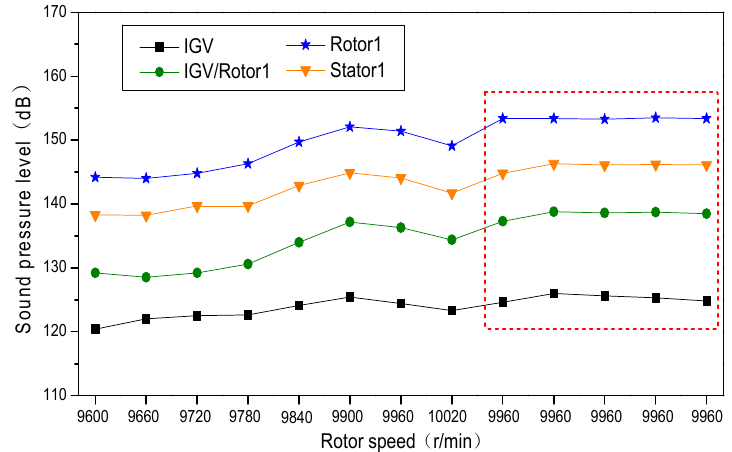
Figure 5. Distribution of sound pressure level at 1402 Hz of noise signals at different measurement positions.